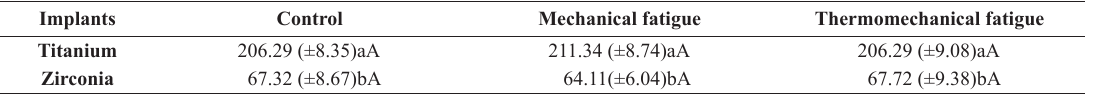
Table 3. Mean (standard deviation) stress (MPa) of fracture strength of zirconia and titanium implants. Implants